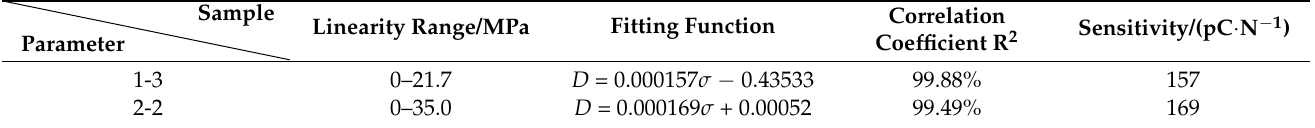
Figure 4. Calibration of quasi-static sensitivity. Table 1. Linear fitting parameters of quasi-static